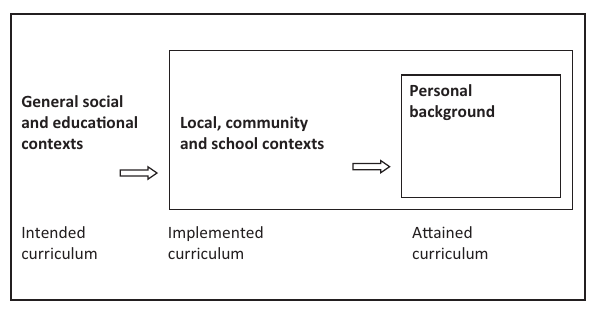
FIGURE 1: Conceptual framework for international comparative